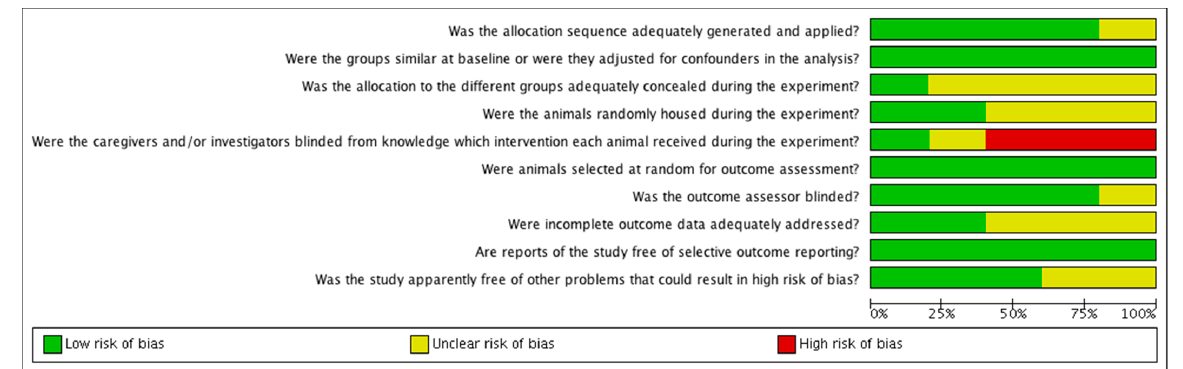
Figure 2. Risk of bias graph: review authors' judgements about each risk of bias item presented as percentages across all included studies.